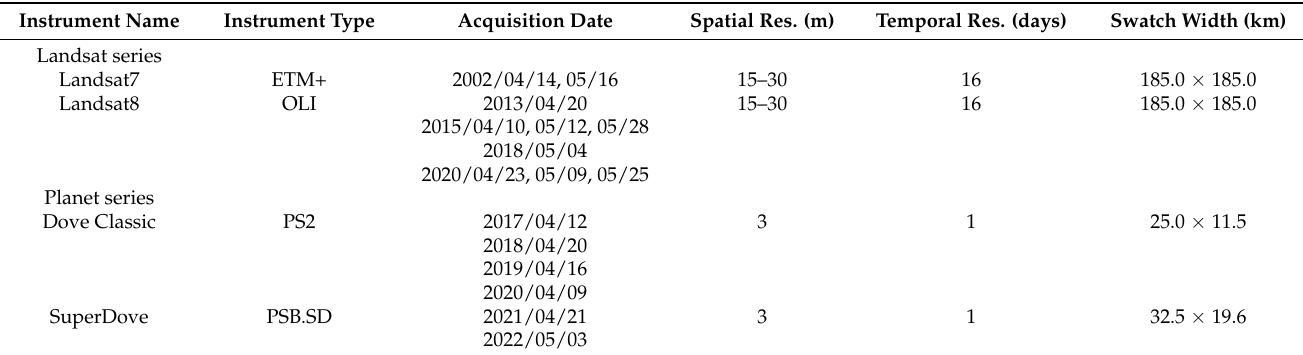
Table 1. Main specification of satellite imagery used in the